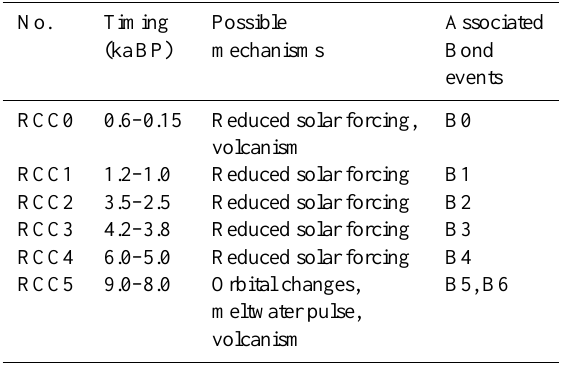
Table 4. List of Holocene rapid climate change (RCC) episodes (Mayewski et al., 2004) including possible forcing mechanisms and temporally associated Bond events (Table